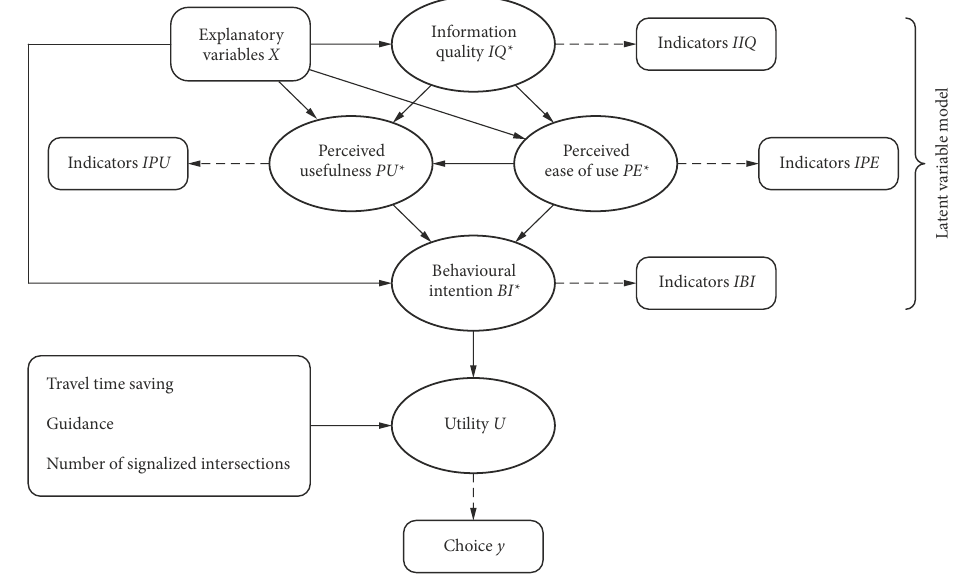
Figure 6. Proposed